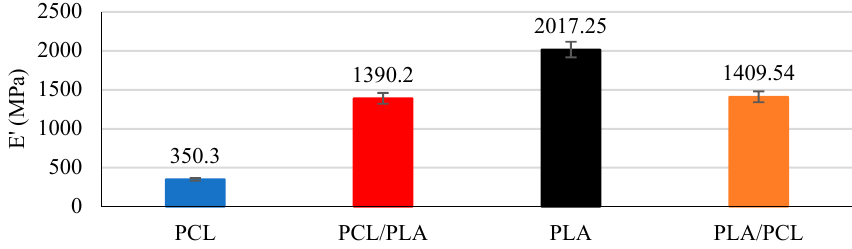
Figure 8. DMA results for PCL, PLA, PCL/PLA and PLA/PCL stents.